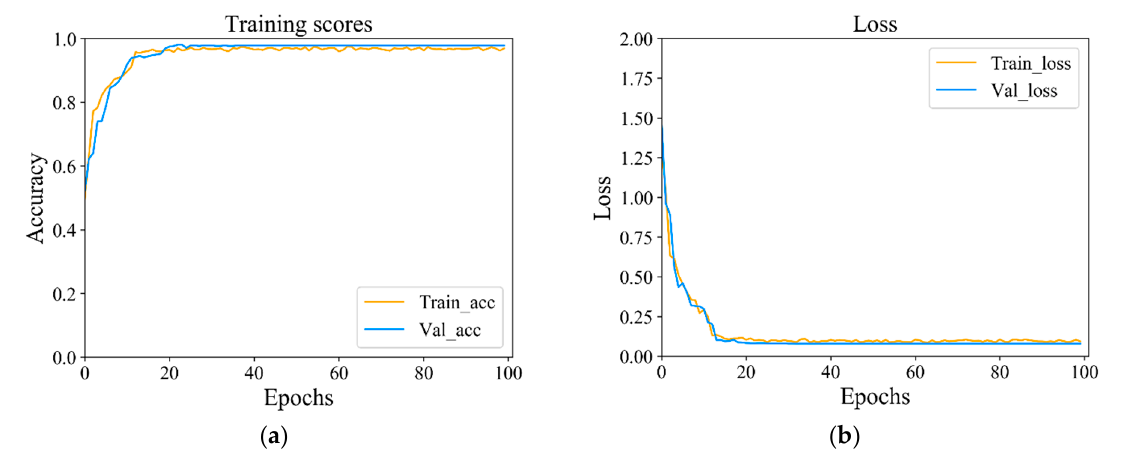
Figure 6. Accuracy and loss curves of training and validation sets: ( a ) the accuracy of training and validation; ( b ) loss curves for training and validation sets.